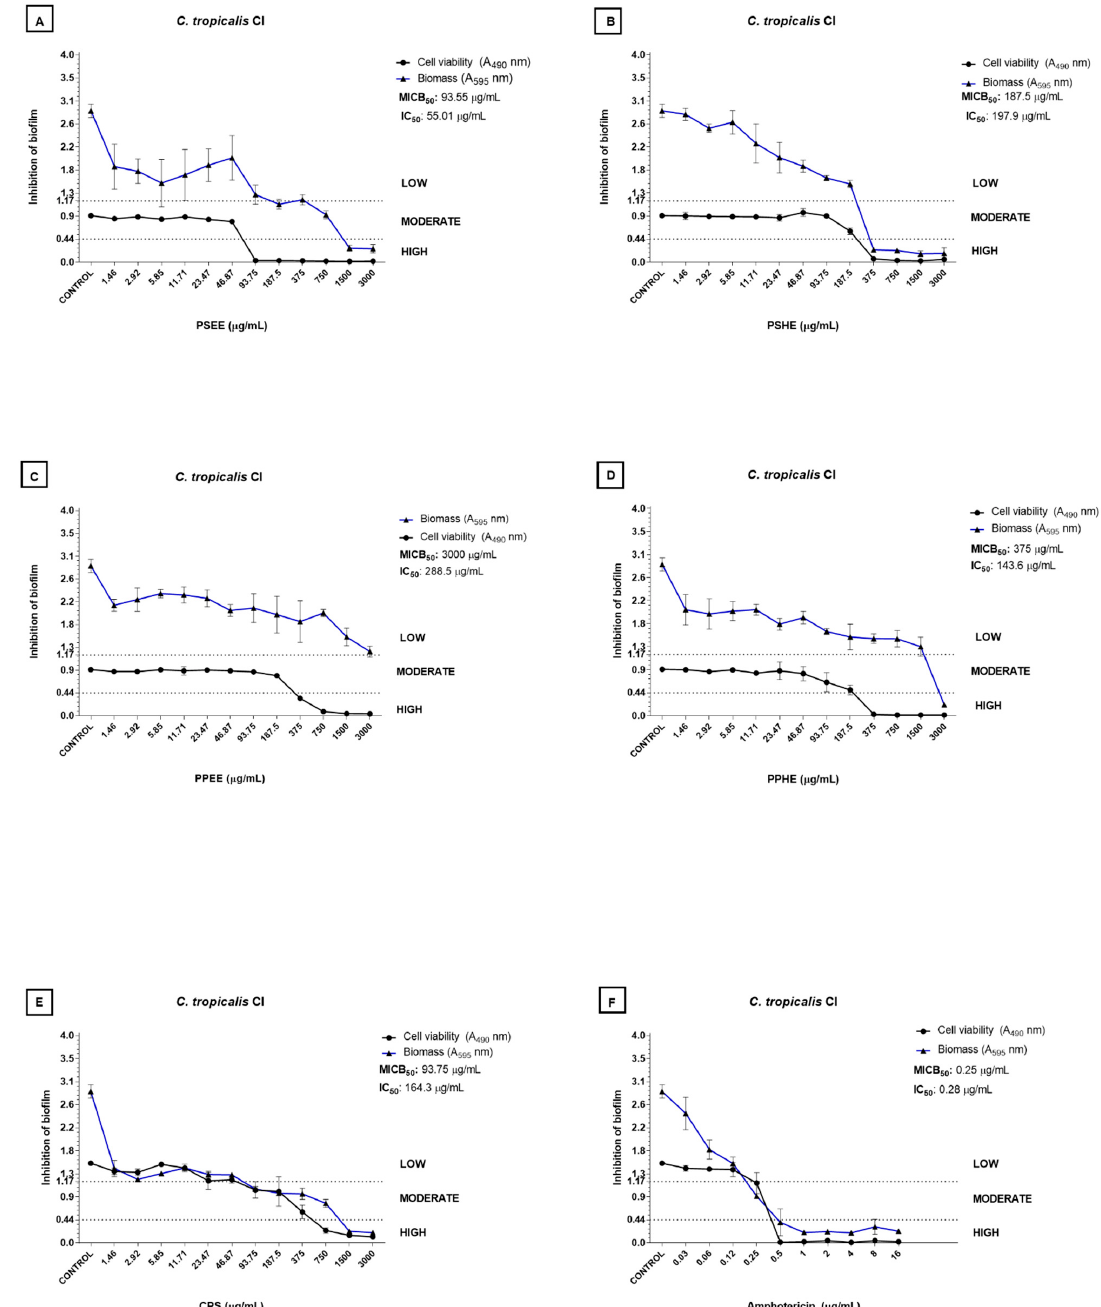
Figure 1. Inhibition of C. tropicalis CI biofilm by the hexane and ethanolic extracts from Capsicum chinense Jacq. peel and seeds. ( A – D ), capsaicin ( E ), and amphotericin B ( F ). The blue line refers to the curve of the OD values of biomass in relation to the concentration of the tested sample. The black line refers to the curve of the OD values of biofilm metabolic activity in relation to the concentration of the tested sample. MICB 50 values refer to the concentration of the sample that was able to inhibit biofilm formation by at least 50% in relation to the biomass [17]. The IC 50 values indicate the sample concentration that was able to inhibit biofilm metabolic activity by half compared to the control group [18]. The low, moderate, and high classification refers to biofilm formation inhibition in biomass, where high inhibition corresponds to OD < 0.44, moderate inhibition corresponds to 0.44 < OD < 1.17, and low inhibition corresponds to OD > 1.17. This stratification was based on the classification of Candida spp. regarding biofilm formation as proposed by Zambrano et al.